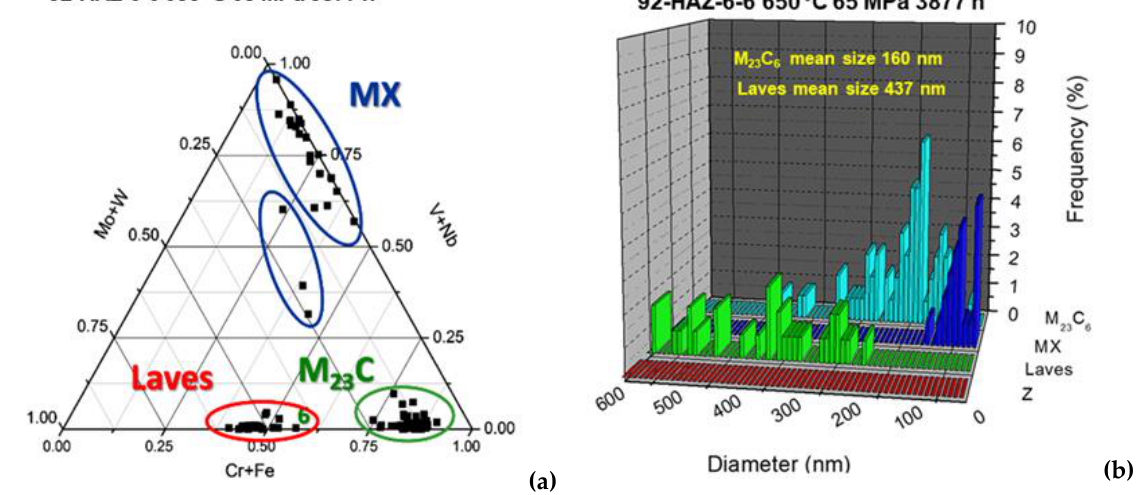
Figure A13. Failed crept cross-weld specimen 92-HAZ-6-6 650 °C 65 MPa 3877 h (sample H). Ternary diagram ( a ) and size distribution ( b ) (TEM analysis).